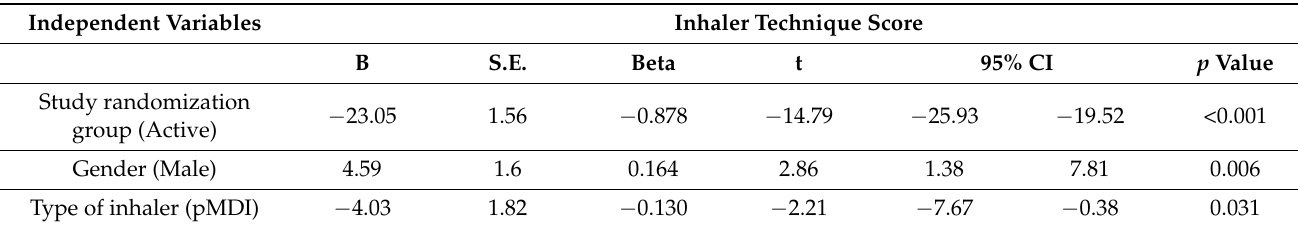
Table 7. Multiple liner regression model for inhaler technique-related factors.